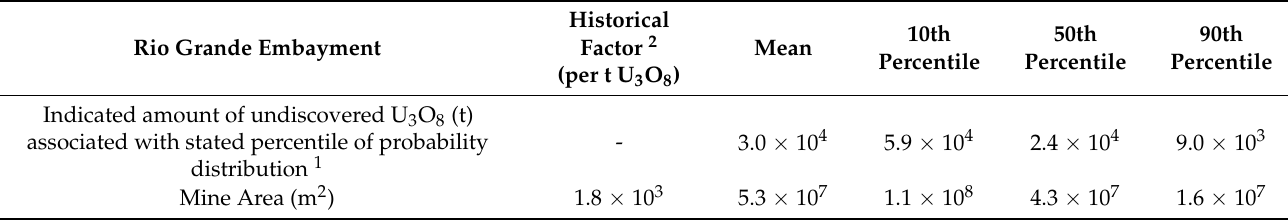
Table 1. Summary of modeled environmental footprints for the amounts of undiscovered uranium indicated at stated percentiles of probability distribution in the Goliad Sand/Willis Sand/Lissie Formation projected in the undiscovered uranium resource assessment